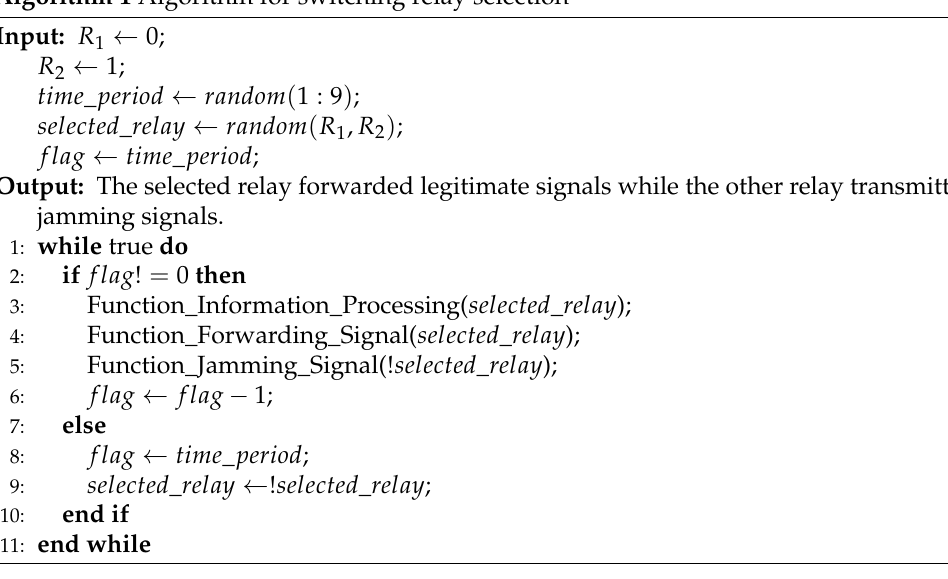
Algorithm 1 Algorithm for switching relay selection